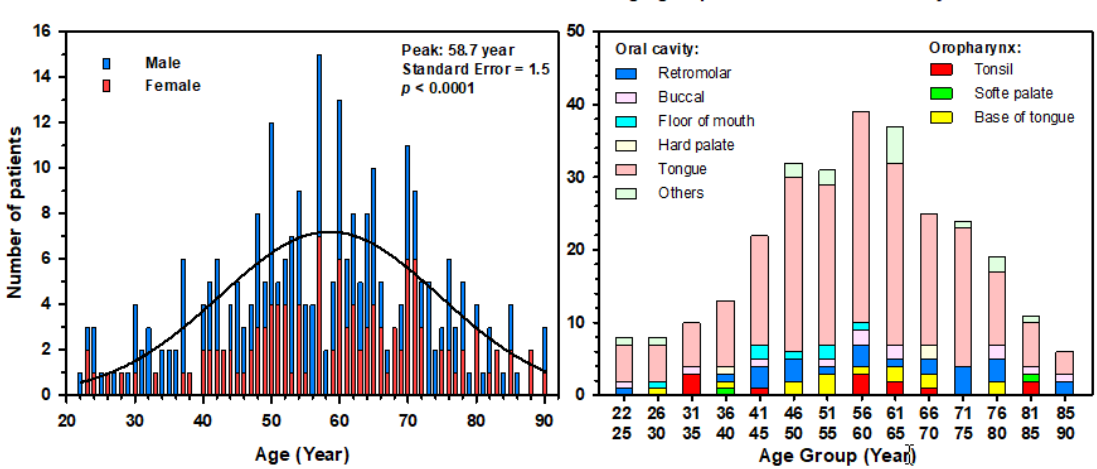
Figure 1. Incidence of head and neck squamous cell carcinoma in 285 Saudi cancer patients. ( A ) Age-distribution by gender of patients. Clustering analysis indicates a peak of maximum occurrence at the age of 58.7 years old. ( B ) Distribution by 5-year age groups of oropharyngeal and oral cavity tumors by sub-anatomical